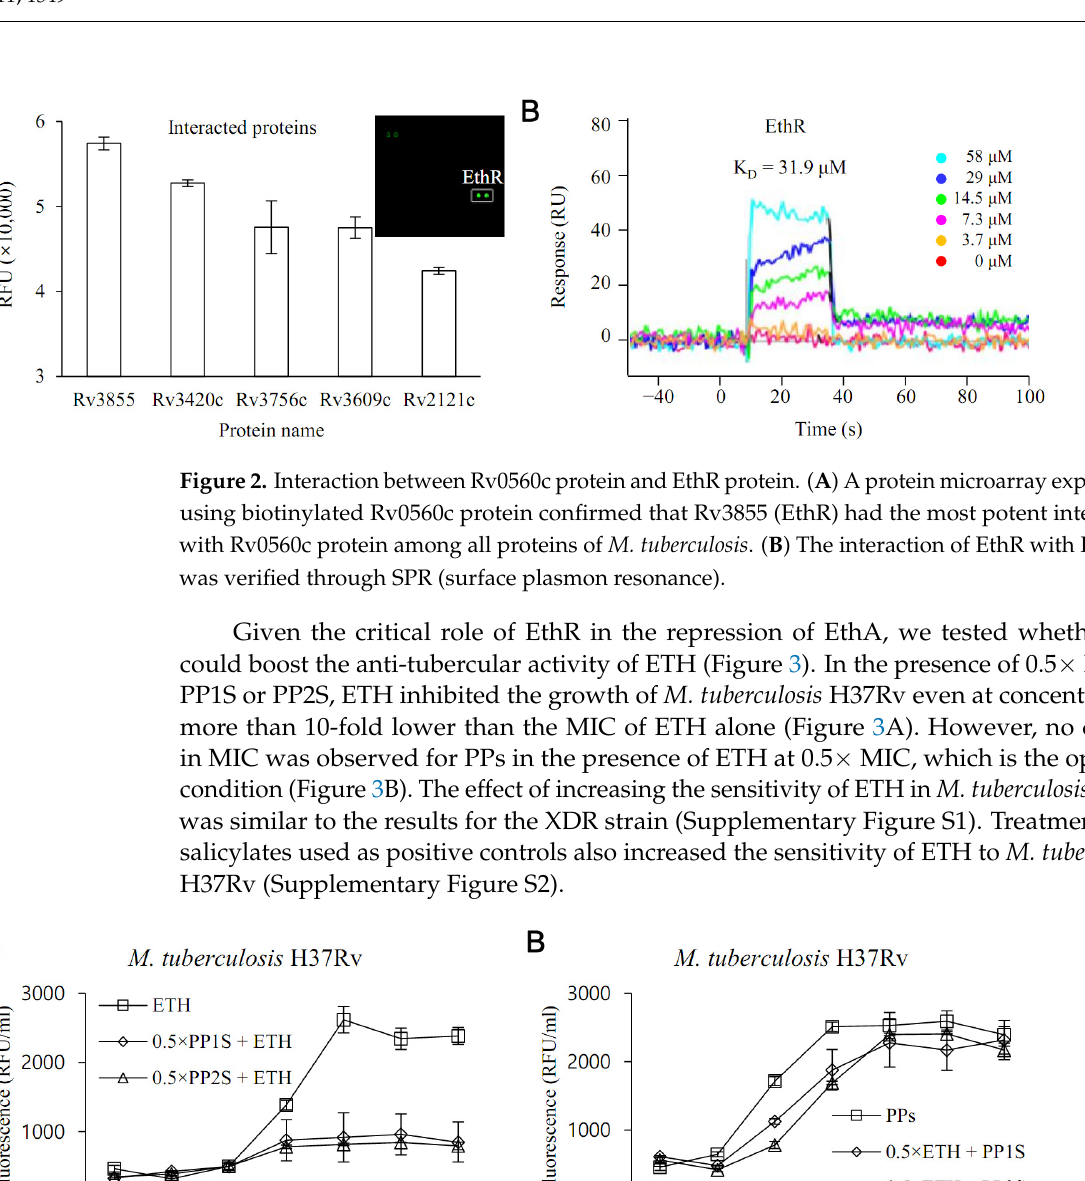
Figure 3. In vitro evaluation of the effect of PPs on the susceptibility of M. tuberculosis to ethionamide (ETH). Whether PPs could increase the anti-tuberculous activity of ETH was tested against the H37Rv strain. ( A ) In the presence of PP at 0.5× MIC, ETH significantly inhibited the growth of M. tuberculosis over concentrations ranging from 0.5× to 0.06× lower than 1× MIC ( p < 0.05). ( B ) Conversely, no significant susceptibility-increasing effect of M. tuberculosis to ETH was observed at the various concentrations of PPs tested in the presence of 0.5× MIC of ETH ( p > 0.05). Values were expressed as mean ± standard deviation, and statistical significance was determined using an unpaired Student’s t-test by comparing fluorescence values of samples treated with either ETH or PPs alone.